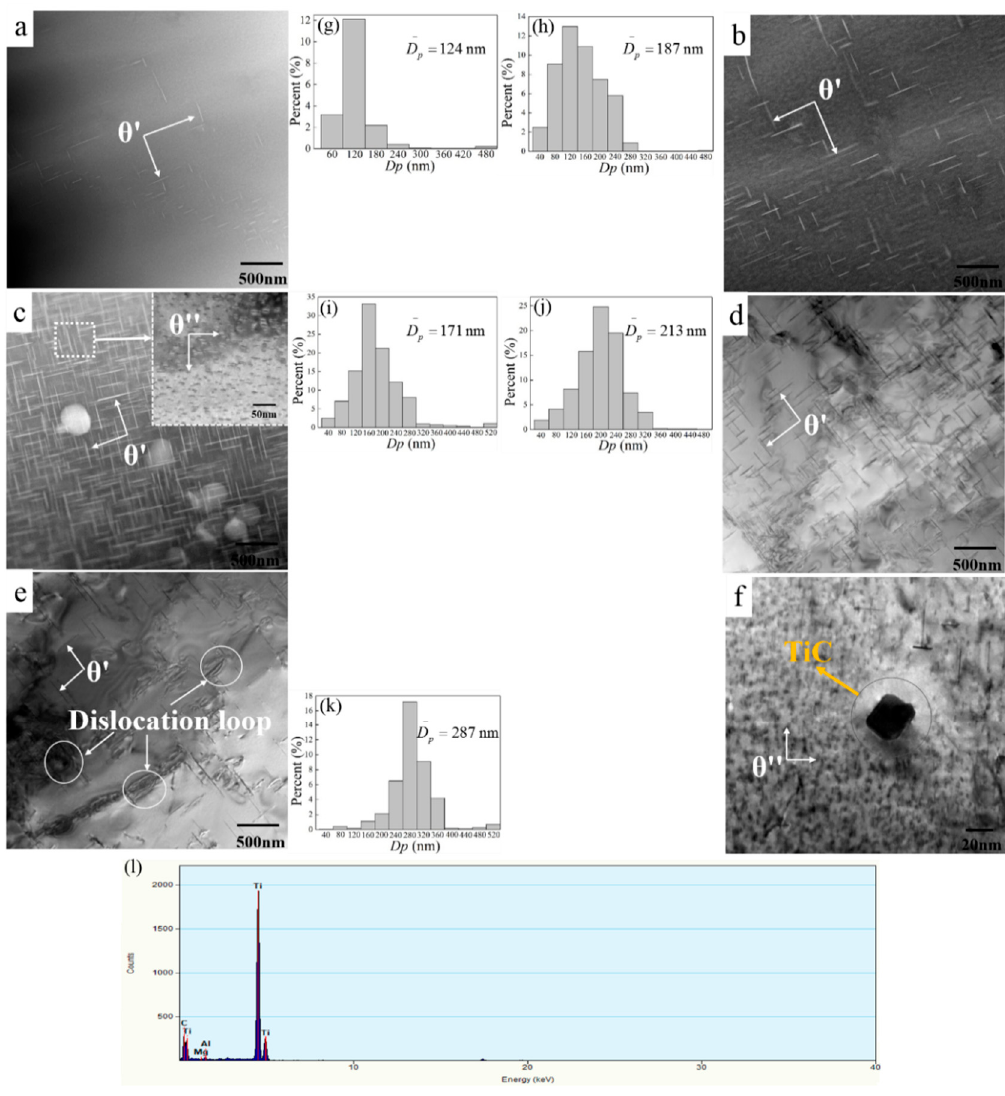
Figure 8. TEM micrographs of the forged and heat-treated TiC/2219 nanocomposite with different nanoparticle contents: ( a ) 0 wt.%, ( b ) 0.5 wt.%, ( c ) 0.9 wt.%, ( d ) 1.3 wt.%, and ( e ) 1.7 wt.%. ( g – k ) the corresponding statistical results of the diameters of the θ′ precipitates in ( a – f ), respectively; ( f ) morphology of TiC nanoparticle in 0.9 wt.% TiC/2219 nanocomposite; ( l ) the TEM-EDS of the TiC nanoparticle.